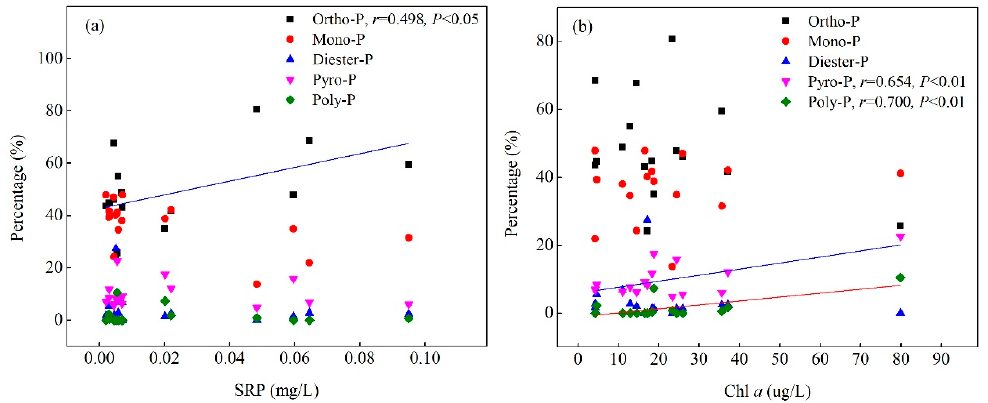
Figure 4. Correlation analysis of NMR P concentrations in PP with ( a ) soluble reactive phosphorus (SRP) and ( b ) chlorophyll a (Chl a ) in Lake